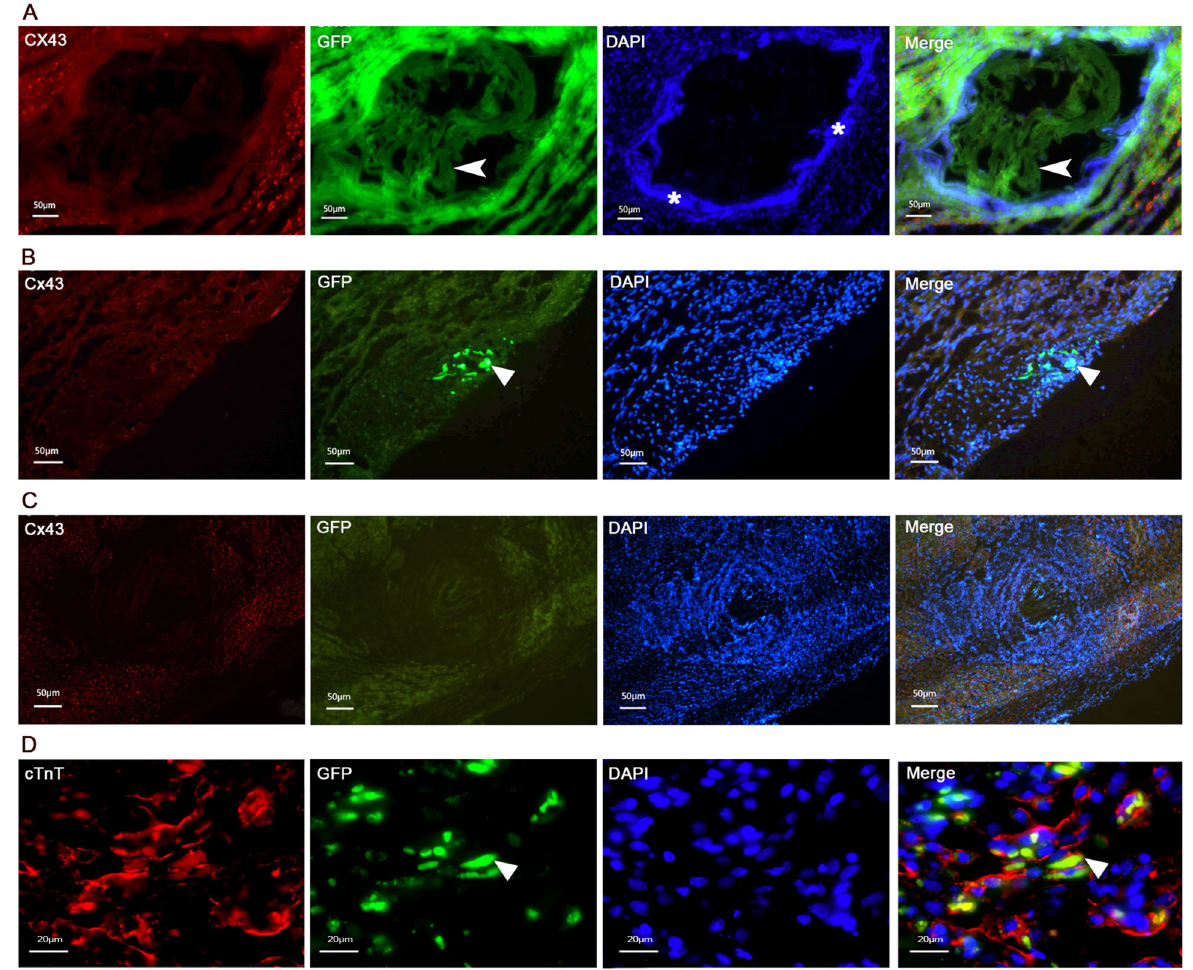
Fig. 5 Effects of ADMSCs-GFP transplantation on mice myocardium and histological alterations. a Survival cells on scaffolds 3 days after transplantation by immuno fl uorescence, arrowhead shows the scaf- folds, asterisk shows connective tissue; b expression of Cx43 in ADMSCs after GFP-ADMSCs based collagen scaffolds transplanta- tion for 7 days, triangle arrow shows the transplanted cells that migrate